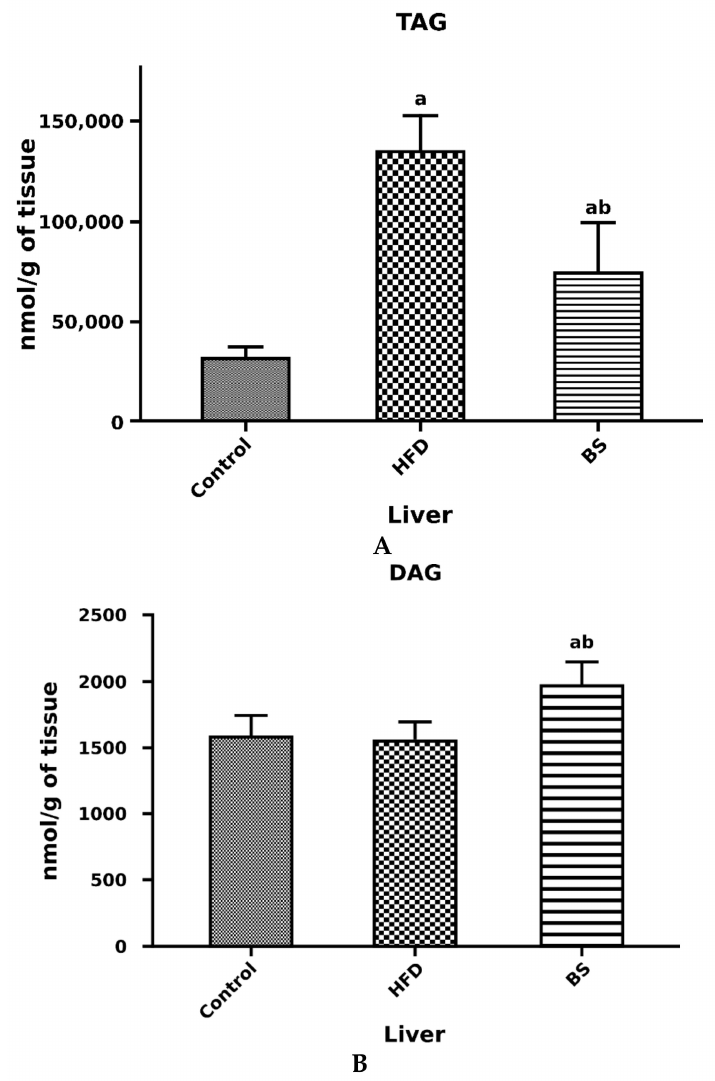
Figure 4. Concentrations of TAG (nmol / g of tissue) ( A ) and DAG (nmol / g of tissue) ( B ) in the liver. Bar heights correspond to averages and error bars represent standard deviations. Statistical significance markers: a—vs. Control ( p < 0.05), b—vs. HFD ( p <